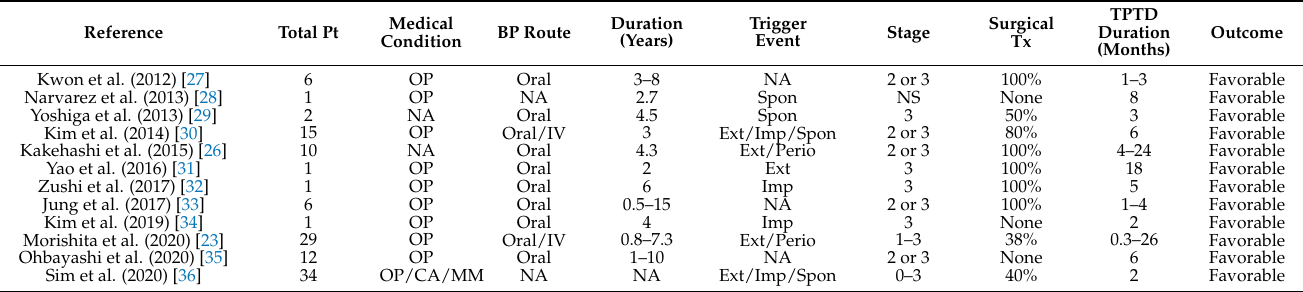
Table 1. Human studies of teriparatide administration for medication-related osteonecrosis of the jaw (MRONJ) treatment in the past 10